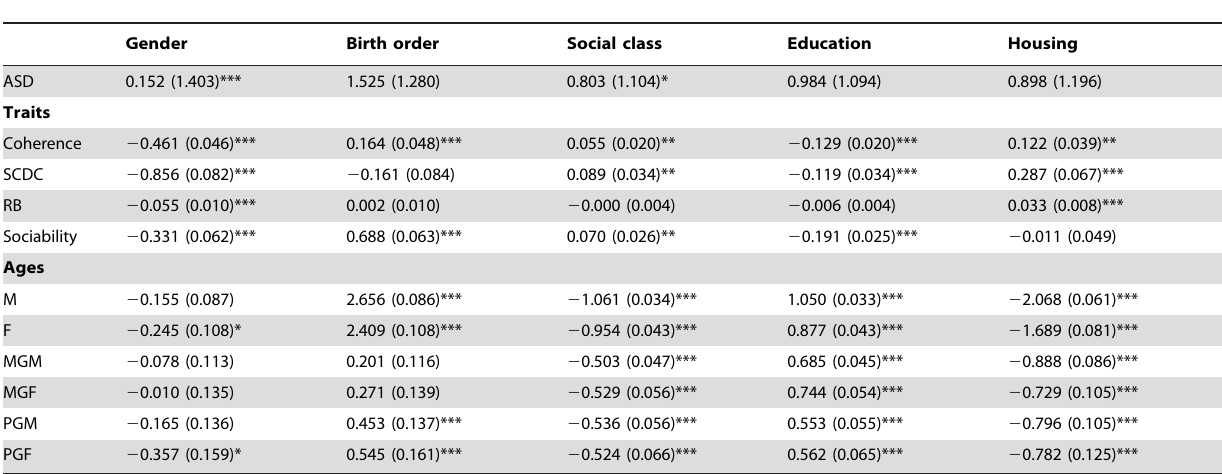
Table 6. Association of ASD, traits and age variables with socio-demographic variables.